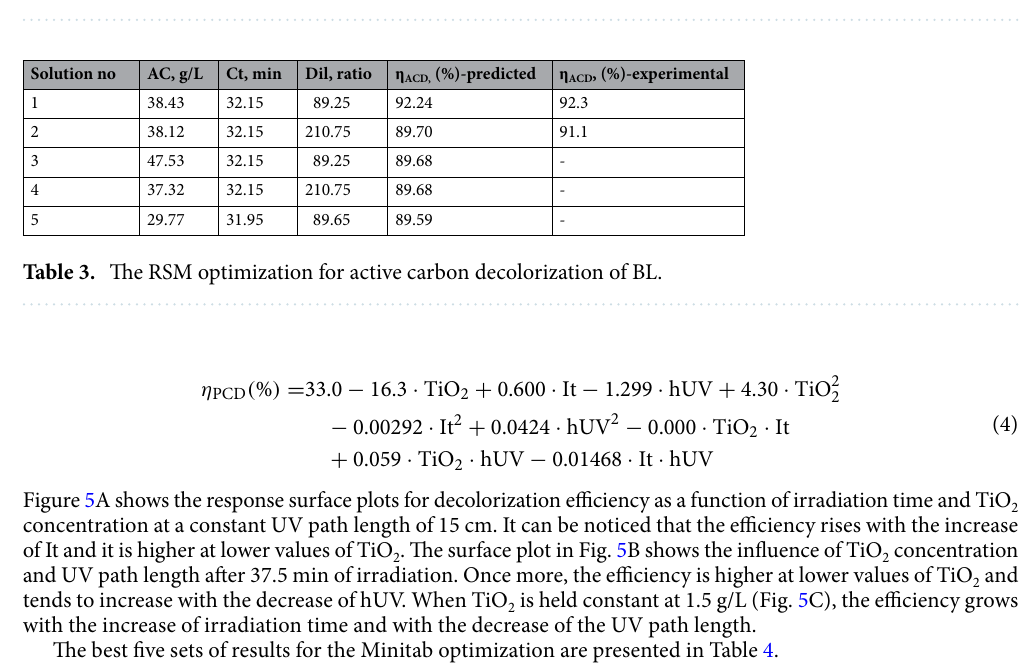
Figure 5A shows the response surface plots for decolorization efficiency as a function of irradiation time and TiO 2 concentration at a constant UV path length of 15 cm. It can be noticed that the efficiency rises with the increase tends to increase with the decrease of hUV. When TiO 2 is held constant at 1.5 g/L (Fig. 5C), the efficiency grows with the increase of irradiation time and with the decrease of the UV path length.